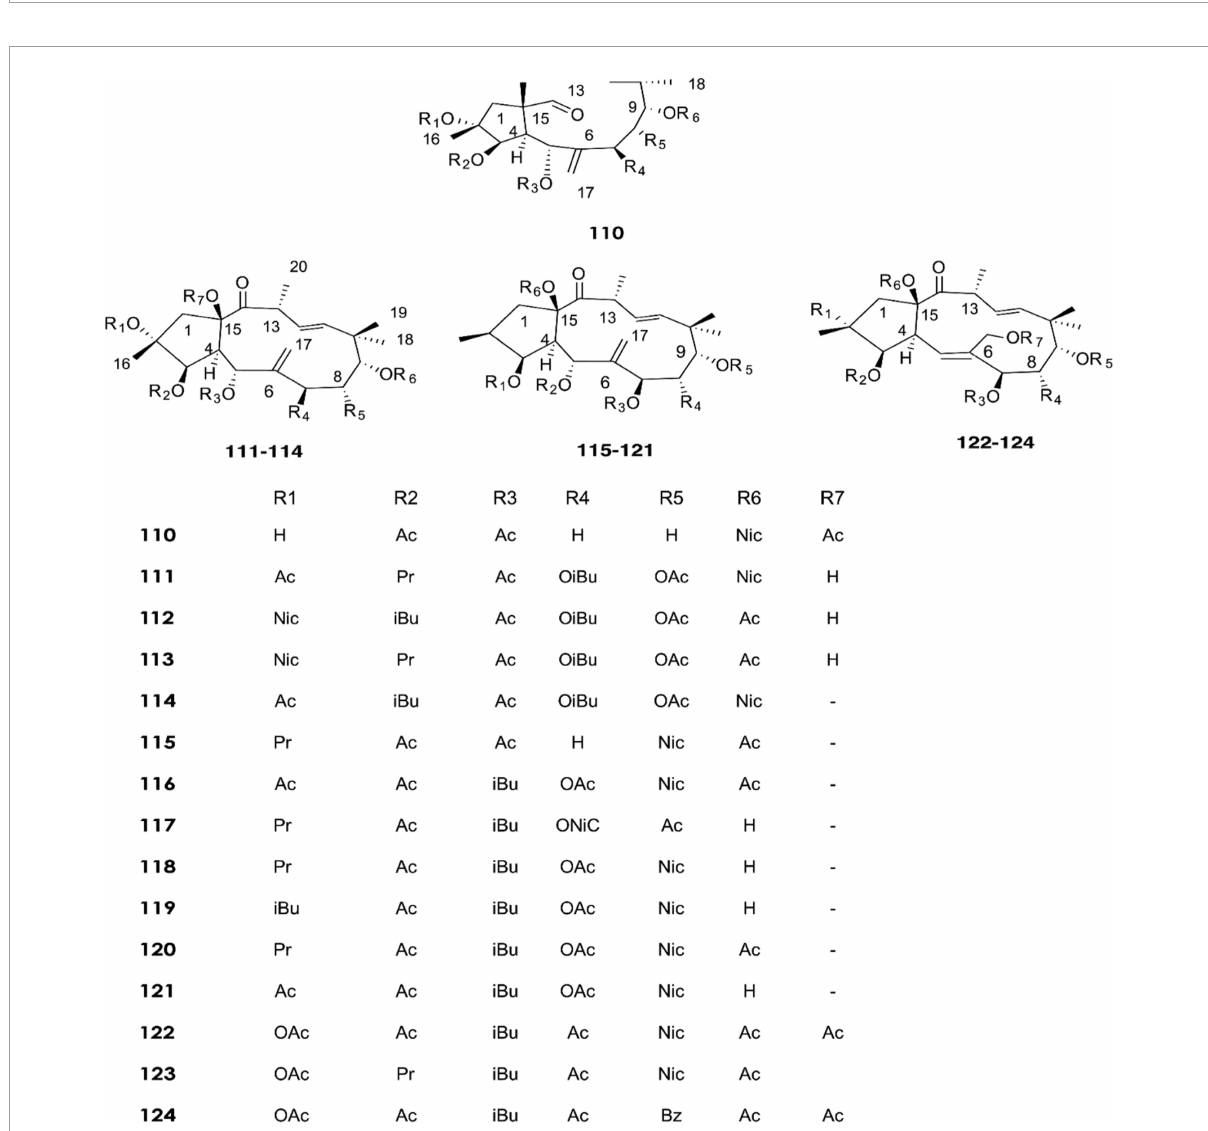
FIGURE6 Structure of chemicals compounds ( 110-124) (Krsti´c et al.,